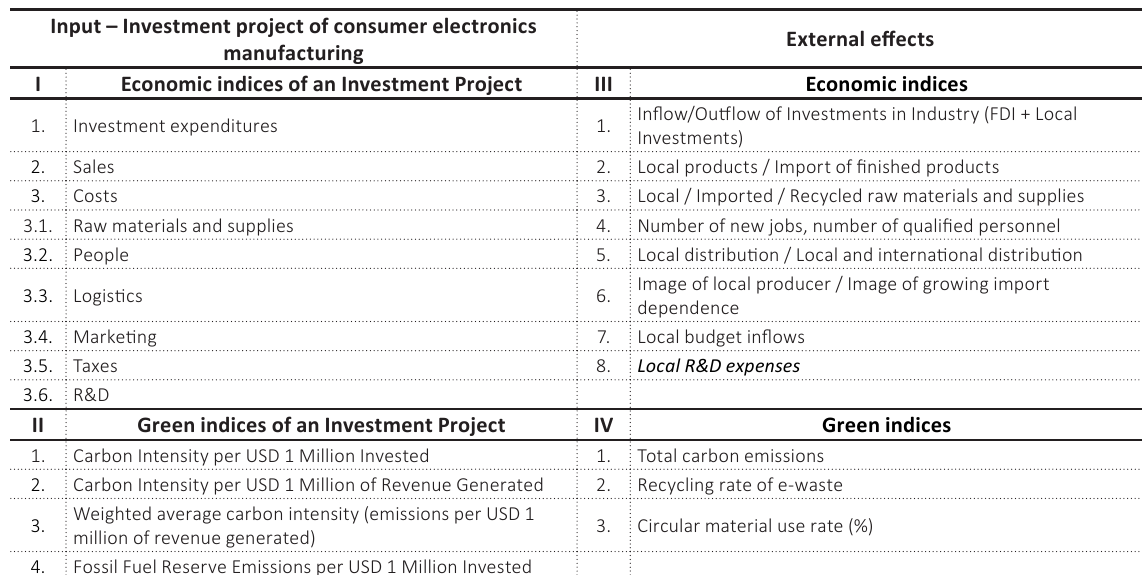
Source: Developed by the